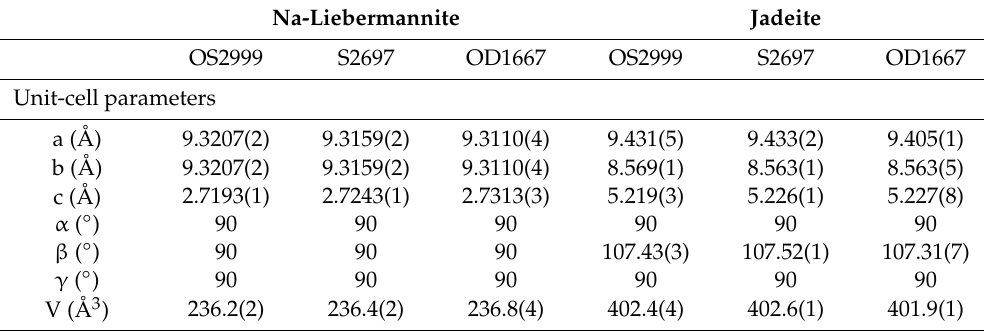
Table 3. Unit-cell volumes of Na-liebermannite and jadeite in the recovered samples. Na-Liebermannite Jadeite OS2999